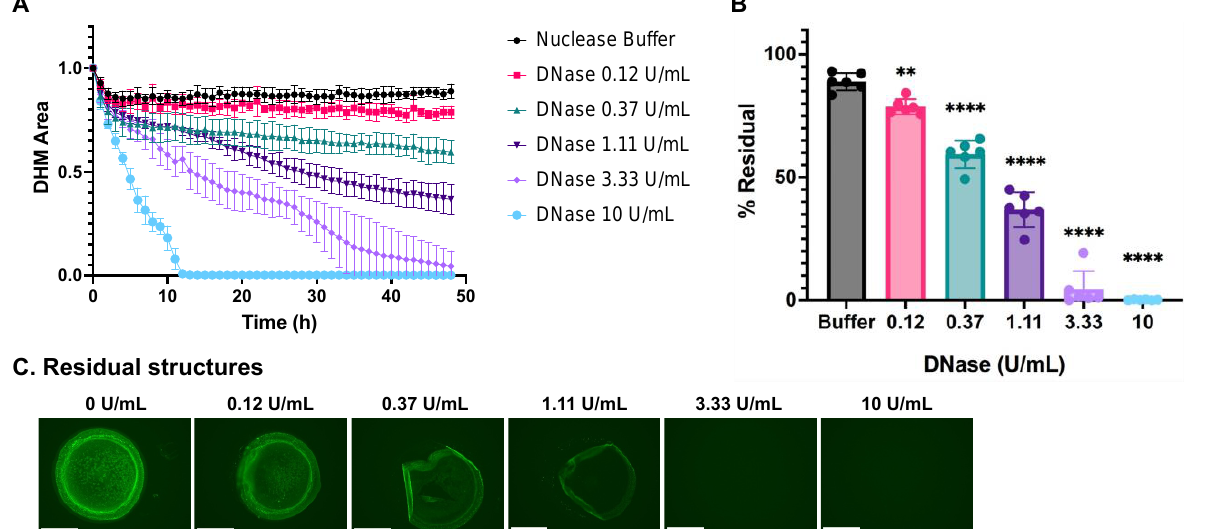
Figure 3. Dose-dependent degradation of DHMs by DNase I. DHM area over time during nuclease incubation is represented in kinetic curves ( A ) and end-point %Residual ( B ) plots. DHM residuals were compared with the control group, nuclease buffer, by one-way ANOVA, ** p < 0.01, and **** p < 0.0001. ( C ) Residual structures were visualized with fluorescent microscopy after 24 h incubation with a DNase concentration series. Structures were stained with SYTOX Green. The scale bar is 275 μ m. All images are representative of n = 6 replicates per condition.